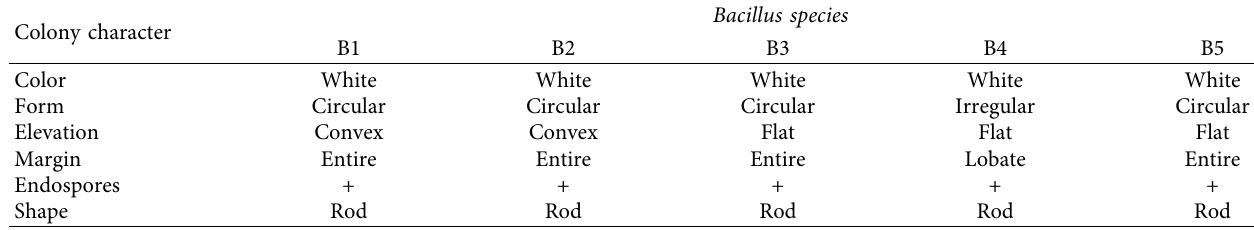
Table 1: Morphological and microscopic results of Bacillus isolates.